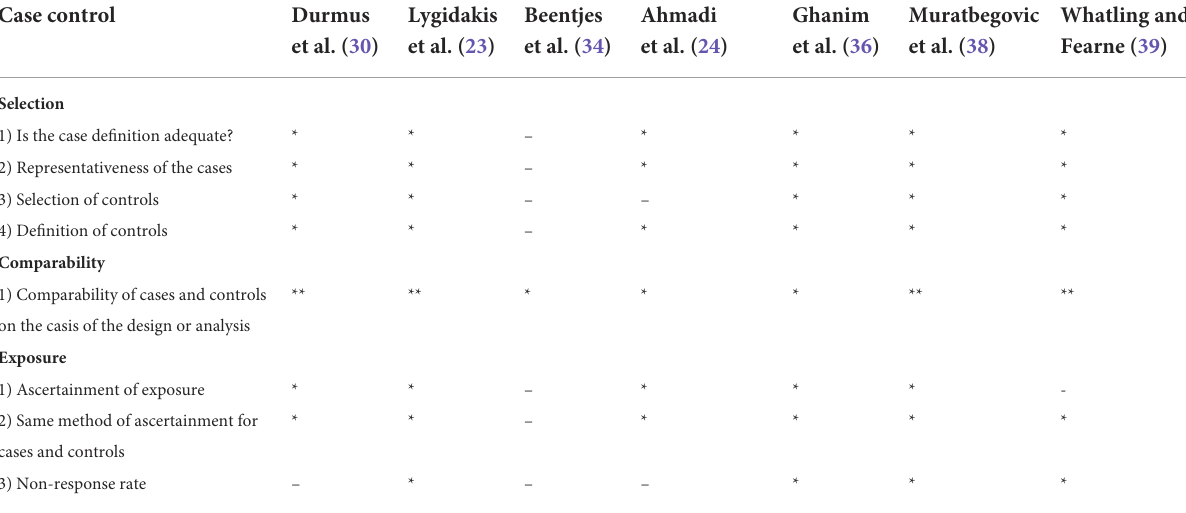
TABLE 2 Newcastle-Ottawa for case-control